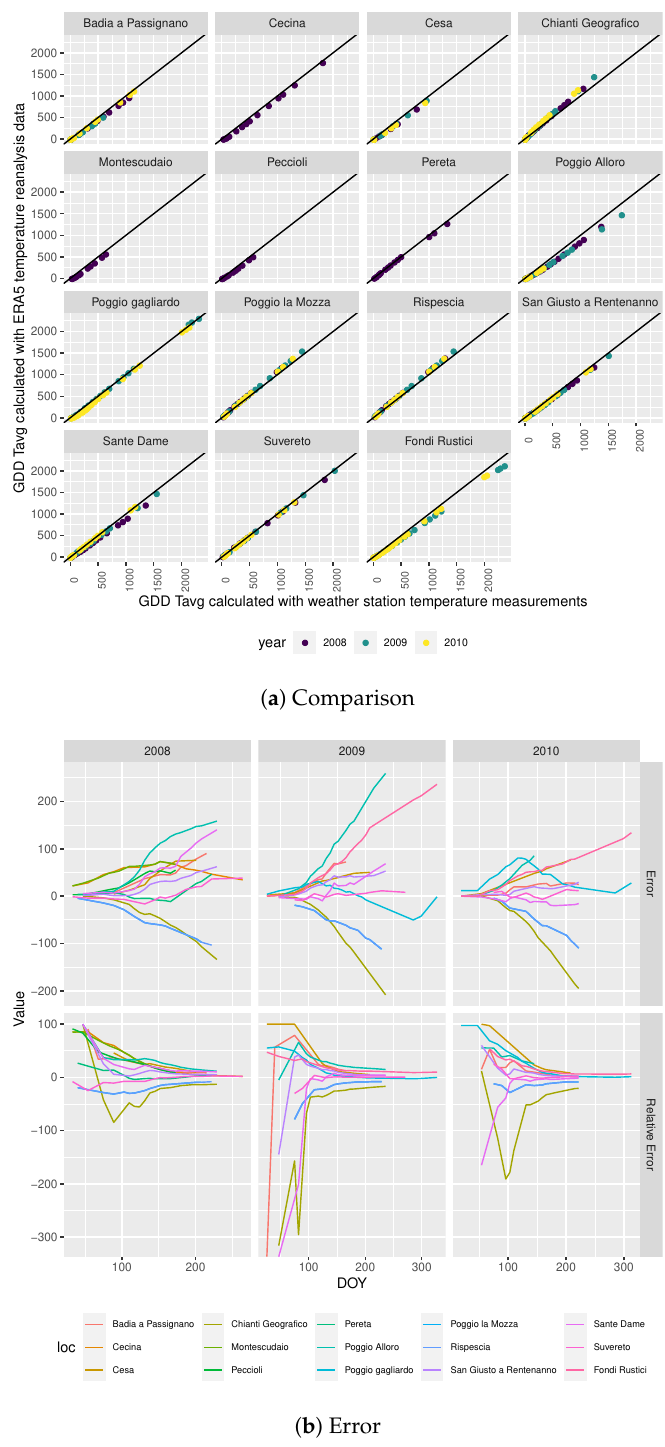
Figure 2. GDD Tavg